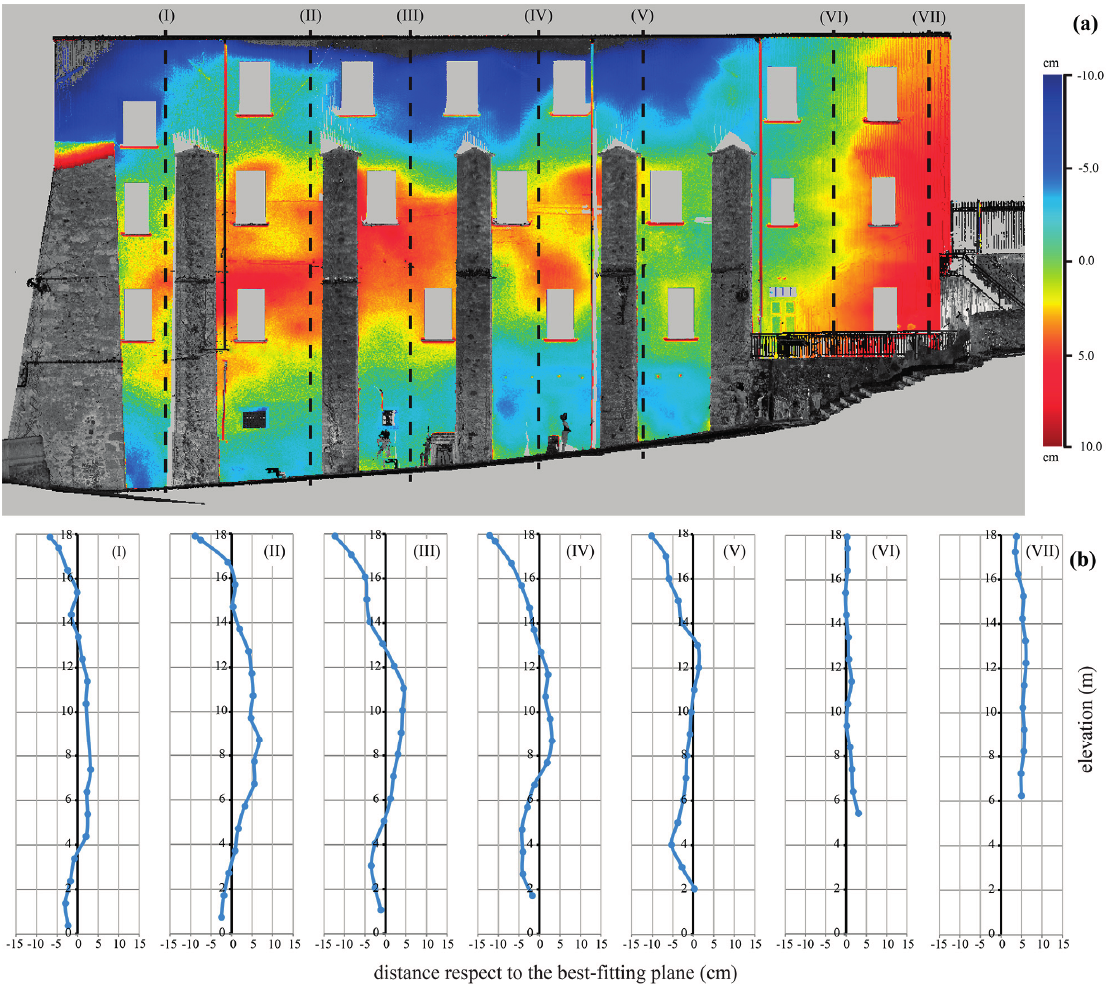
Figure 7. TLS survey of the external wall reinforced by buttresses: ( a ) point cloud and map of the residuals and ( b ) vertical profiles of the distance out of plain with respect to the reference